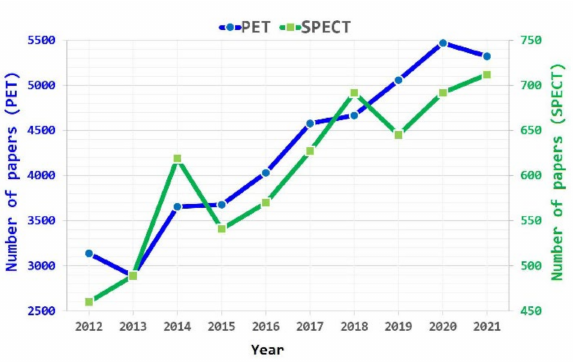
Figure 1. Number of scientific papers related to PET (left axis) and SPECT (right axis) radiopharma- ceuticals over the past 10